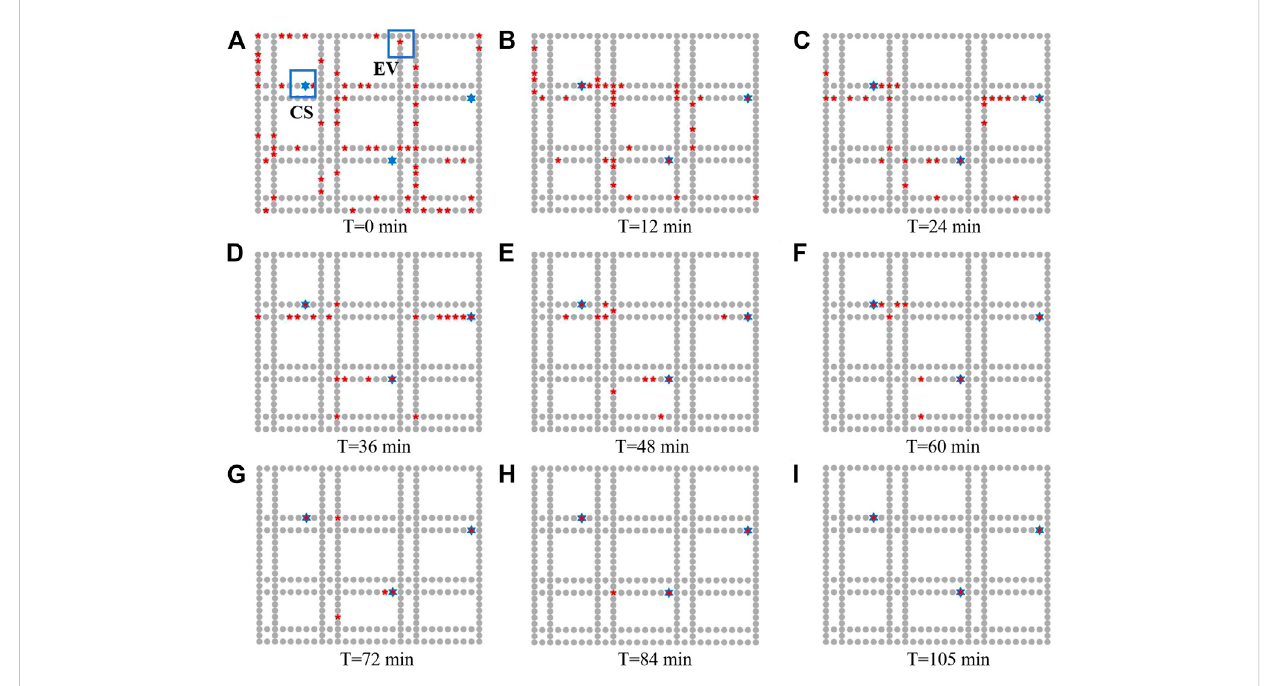
FIGURE 6 Co-navigation process for 70 charging electric vehicles.